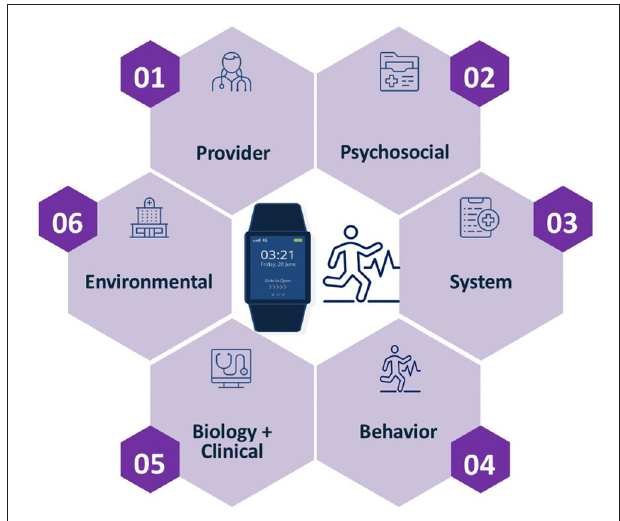
FIGURE 1 | The use of a Pantheoretical framework to generate idiographic profiles of users to optimize digital health and wellness applications